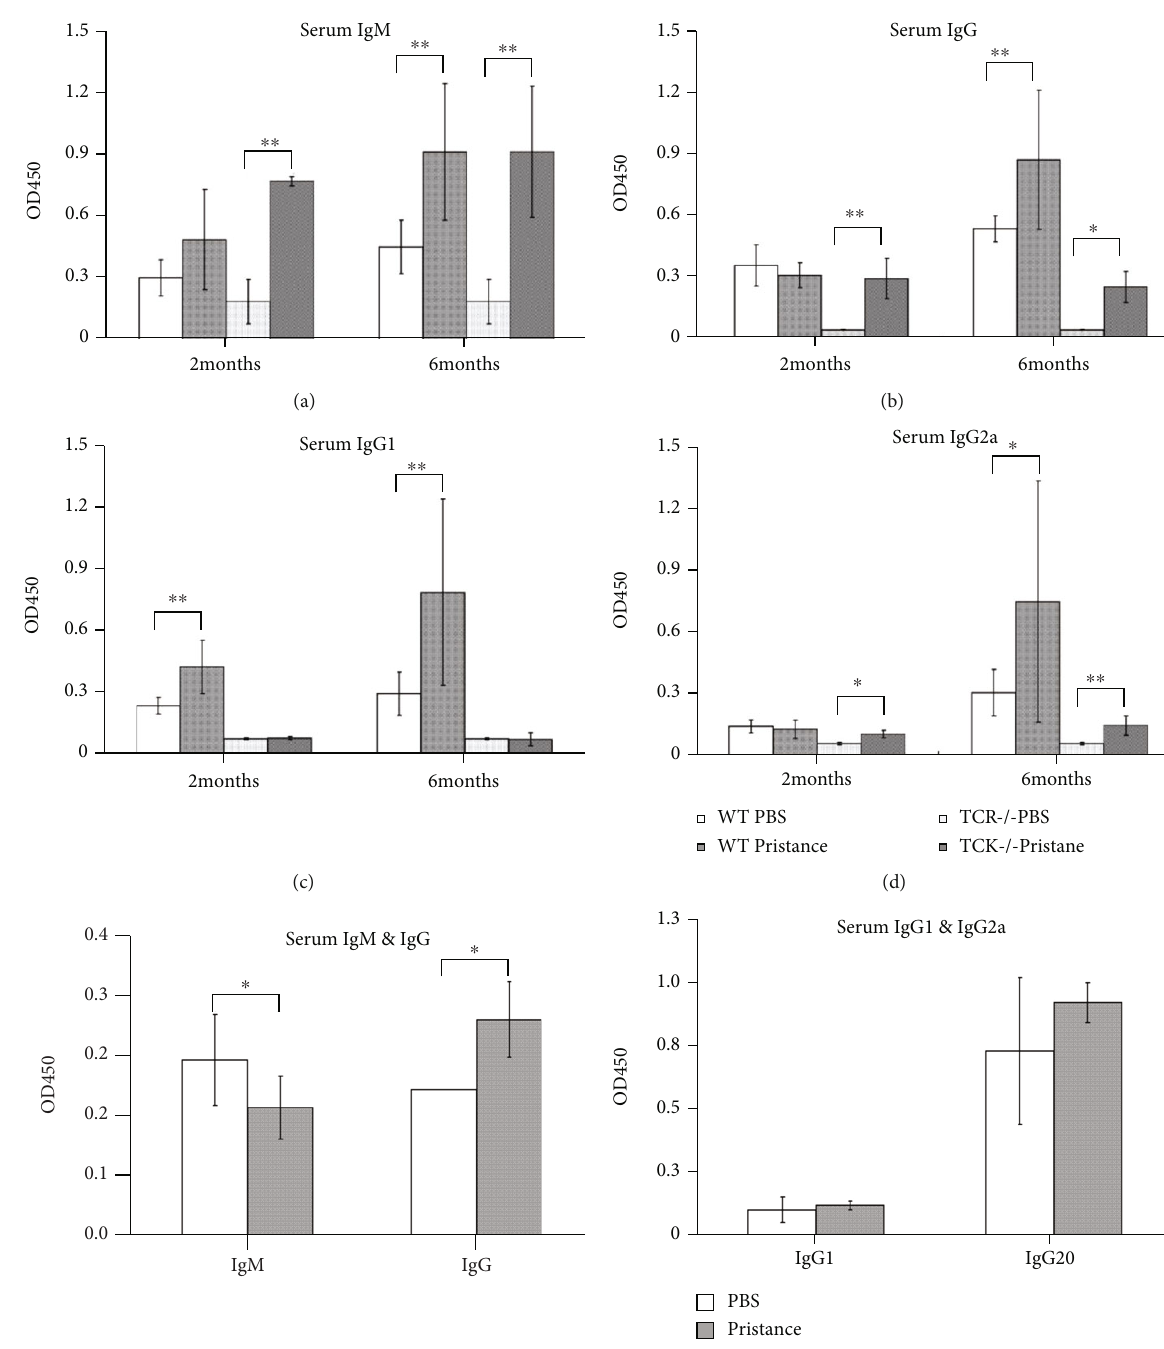
Figure 3: CD4 + T cells are more inclined to promote IgG production in pristane-induced lupus-like mice. Serum from PBS or pristane- treated C57BL/6 and TCR α -/- mice (on a C57BL/6 background) were subjected to the determination of total IgM/IgG and IgG subtype IgG1/IgG2a by the ELISA assay. OD value was detected to represent IgM (a), IgG (b), IgG1 (c), and IgG2a (d) levels in the serum of 450 the mice. CD4 + T cells sorted from PBS and pristane-treated C57BL/6 mice were i.v. injected into TCR α -/- mice ( 1 × 10 5 cells/body), respectively, and the serum of TCR α -/- mice were collected 14 days after CD4 + T cells were transferred. The levels of total IgM/IgG (e) and IgG subtype IgG1/IgG2a (f) in the serum were determined by ELISA. Each group had at least six mice for the analysis. ∗ p < 0 : 05 ; ∗∗ p < 0 : 01